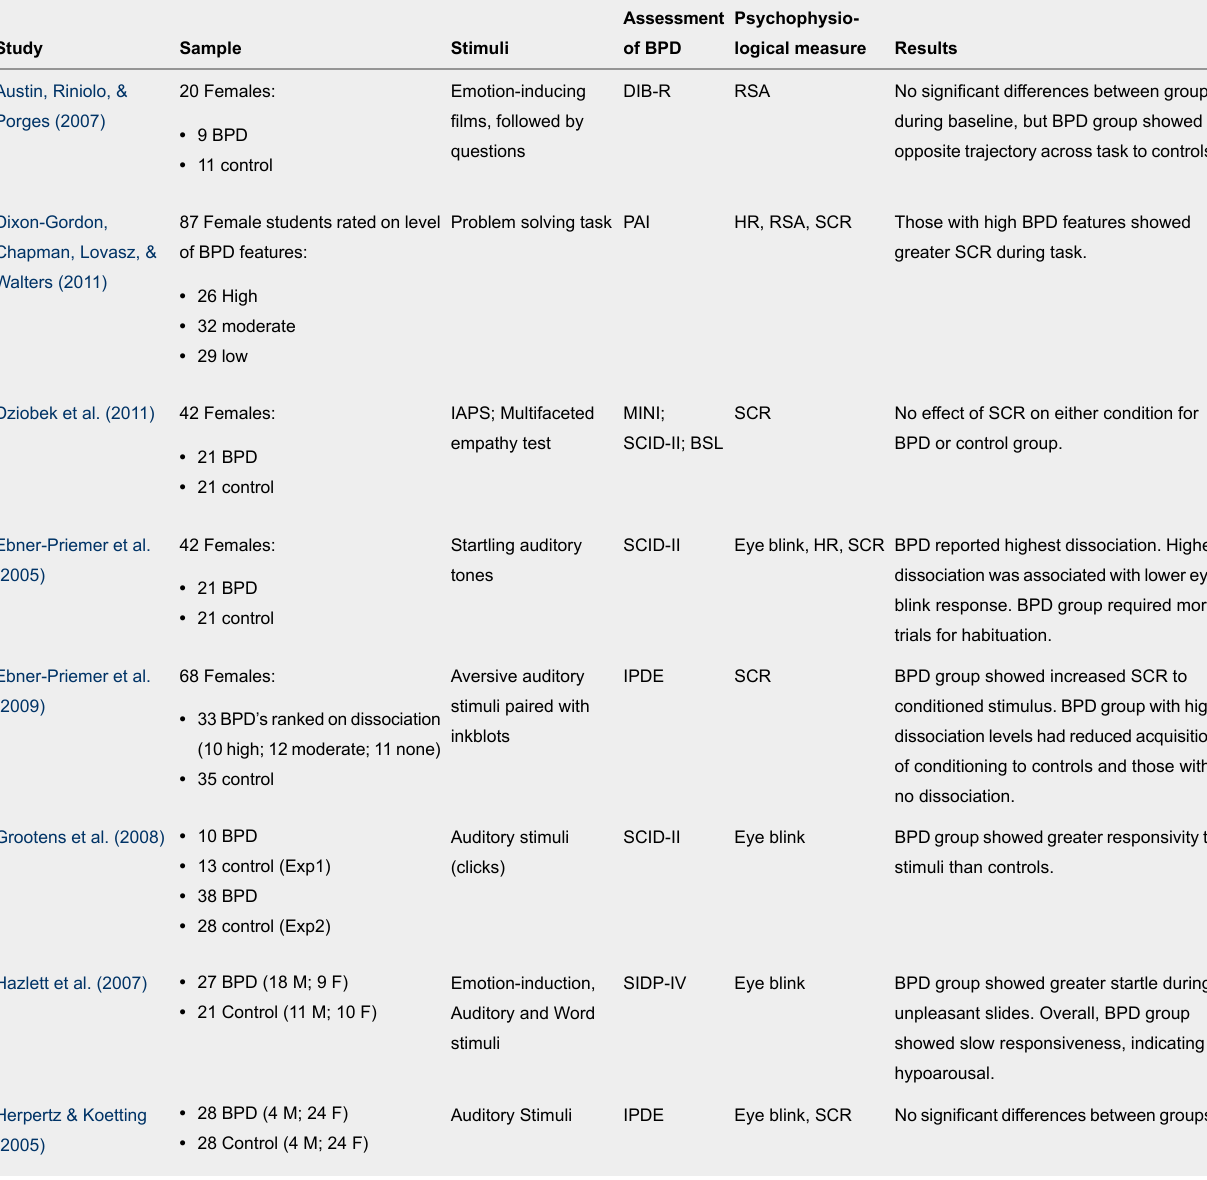
Details of Psychophysiological research of BPD